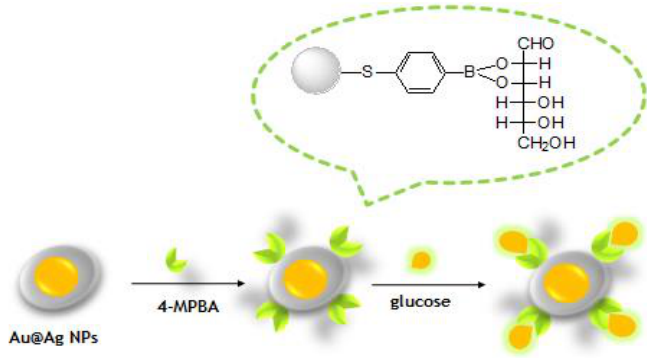
Figure 4. Synthesis of 4-MPBA–modified Au@Ag NPs for glucose detection.